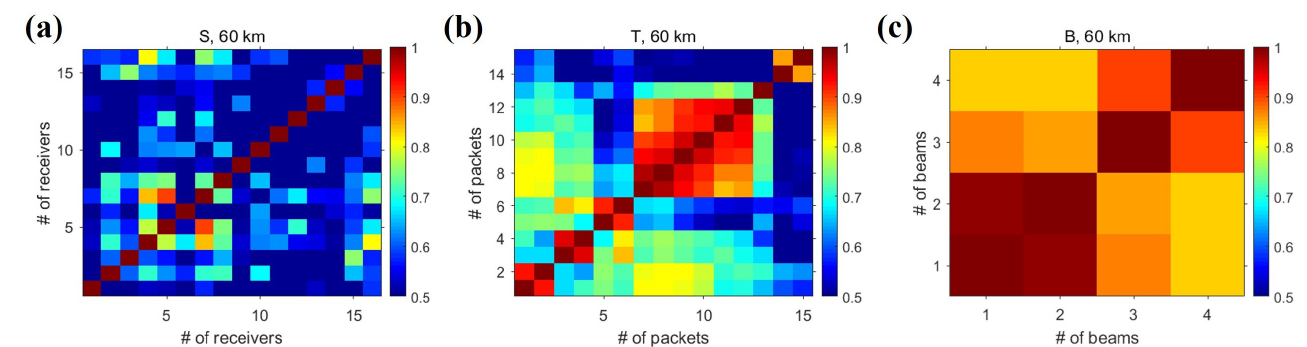
Figure 10. Co-diversity interference, Q ij , for the three diversity methods. All plots show the correla- tion coefficient between the channel impulse responses estimated from two sets of data, i.e., the data obtained by two receivers from the point of view of the spatial diversity. The off-diagonal elements of Q ij represent the channel variability within the diversity scheme. ( a – c ) show the Q ij of the spatial, temporal, and beam diversity methods,